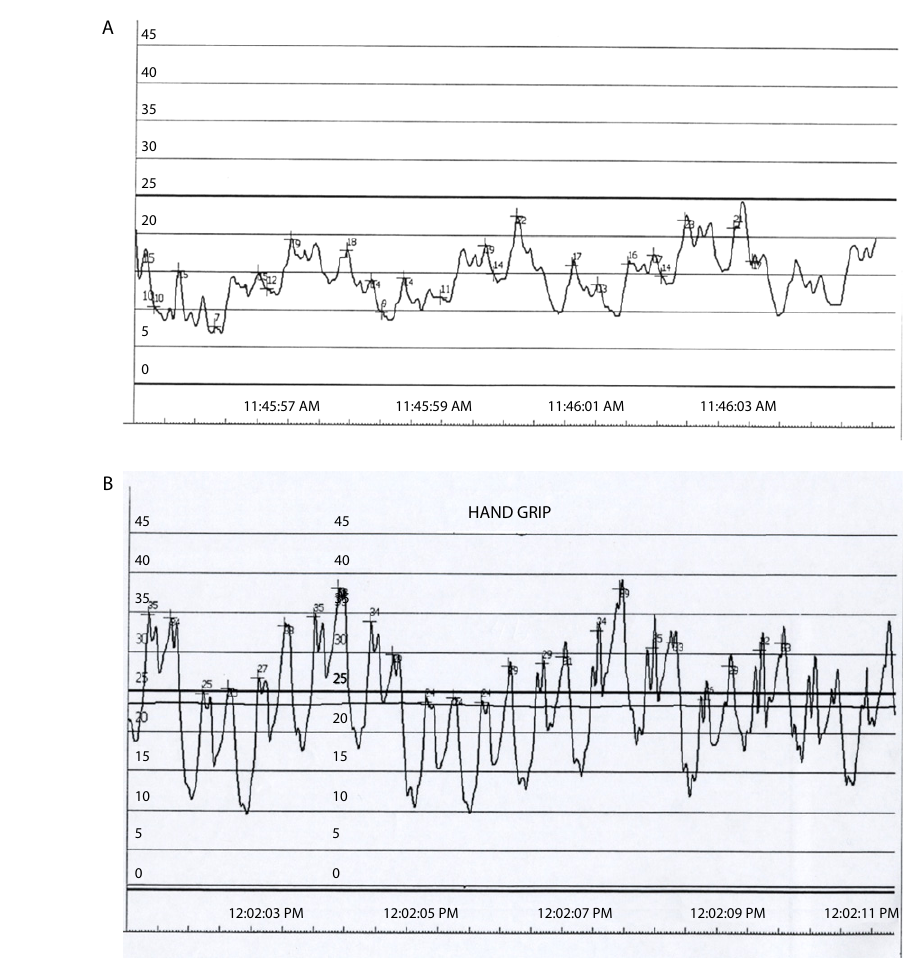
Figure. 4 Pulmonary capillary wedge pressure (PCW) at rest (left panel, 4A) and during handgrip exercise (right panel, 4B) is shown for a patient with AR. Afterload increased by handgrip causes a substantial increase in